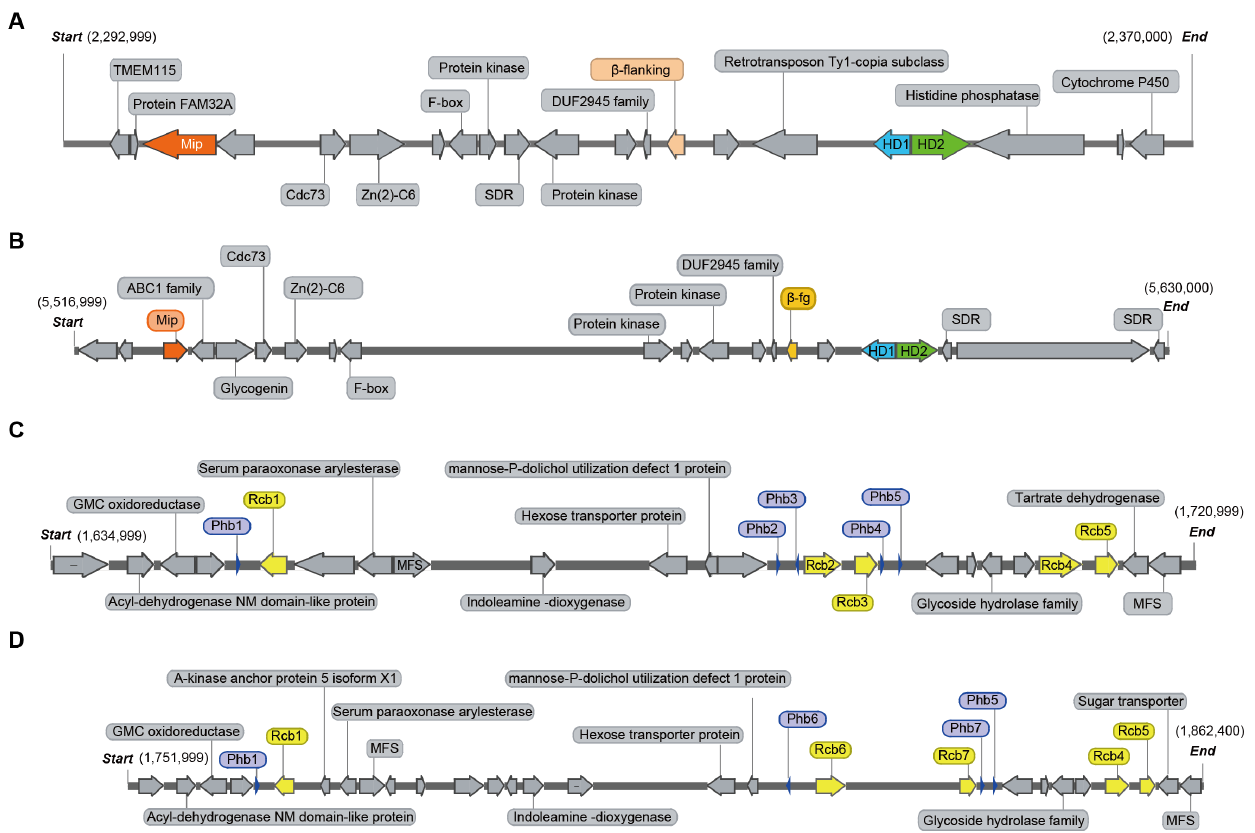
Figure 6 . Distribution of genes in the matA and matB loci of the two monokaryons. ( A ) SP3 matA. ( B ) SP30 matA. ( C ) SP3 matB. ( D ) SP30 matB. Homeodomain (HD), pheromone receptor (RCB), pheromone (phb), mitochondrial intermediate peptidase gene (mip), β-flanking gene (β-fg).